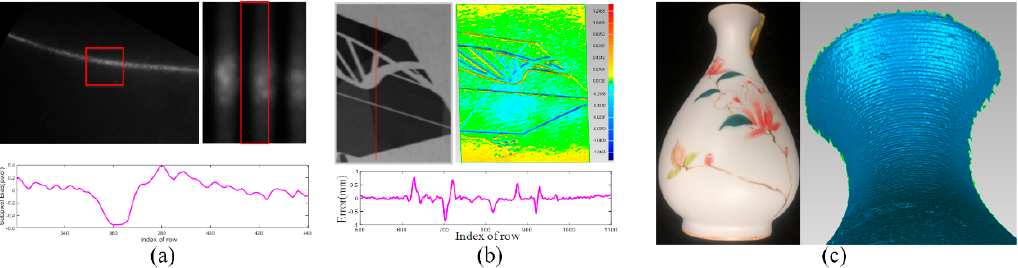
Figure 4. Example of biased detection. ( a ) The detection bias is introduced due to specular reflection; ( b ) The detection bias is introduced due to surface texture; ( c ) The apparent unevenness due to glossy reflection and surface texture.